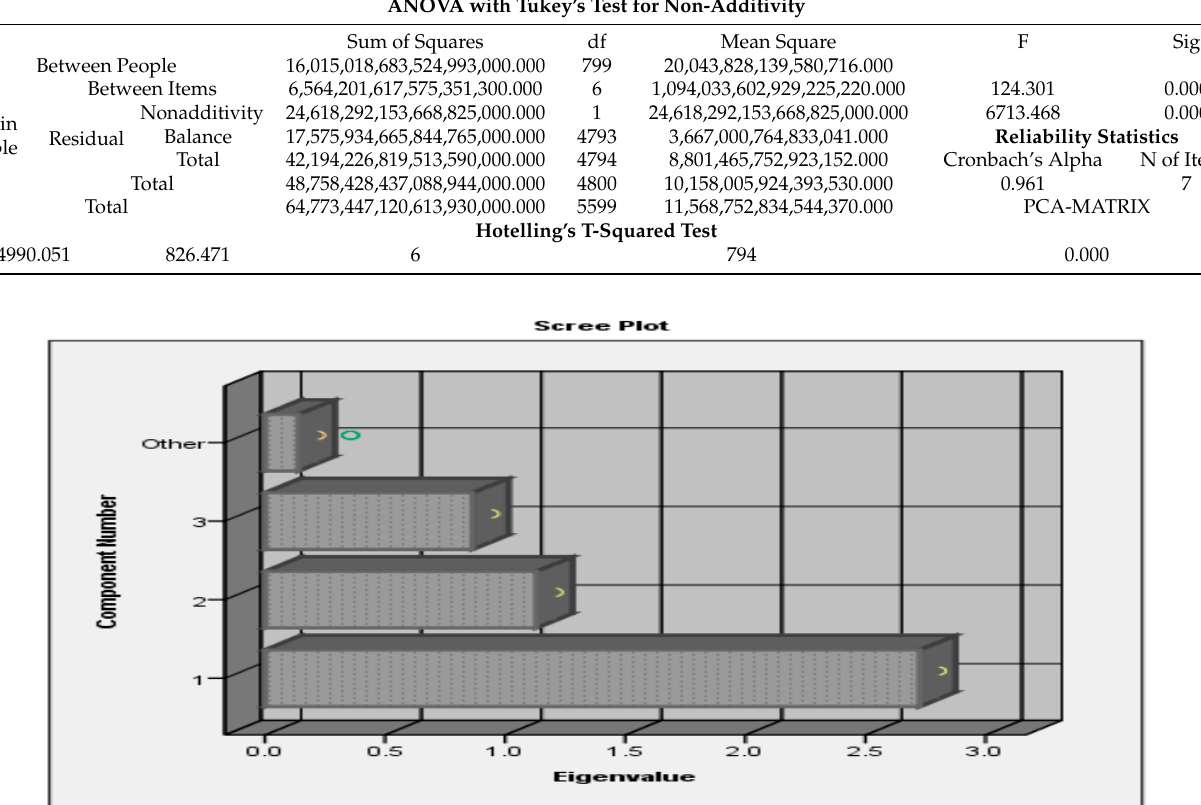
Figure 3. Scree plot of the sustainable profit factor in